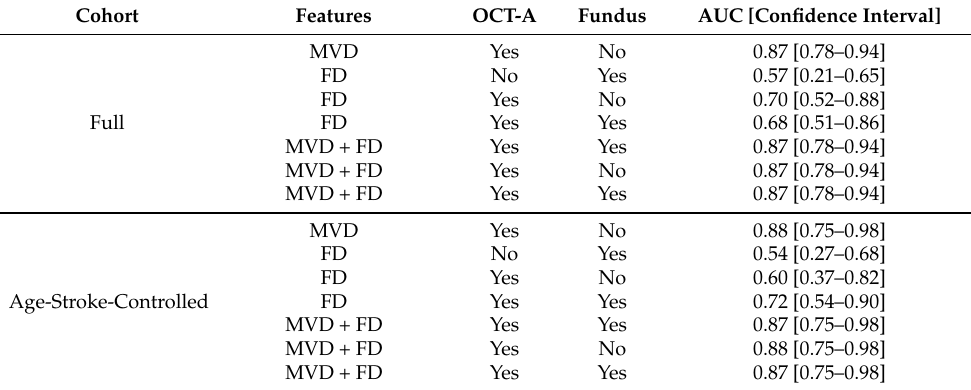
Table 4. AUCs with their confidence intervals on different features and their combinations with full and age-stroke-controlled cohorts. The columns OCT-A and Fundus represent which images were used to obtain the